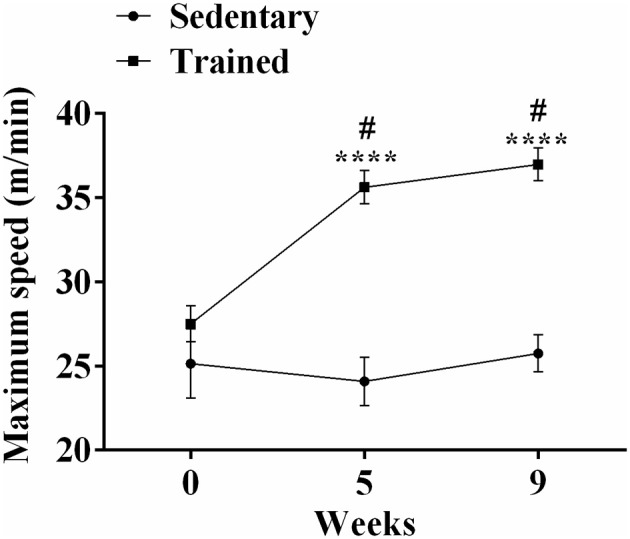
Trained mice have significantly higher maximal speed values than sedentary mice. The experimental groups were composed of 60 trained mice and 60 sedentary mice. ****P < 0.0001 comparing trained group with sedentary group for each week. #P < 0.0001 comparing in trained group between week 0, 5, and 9.